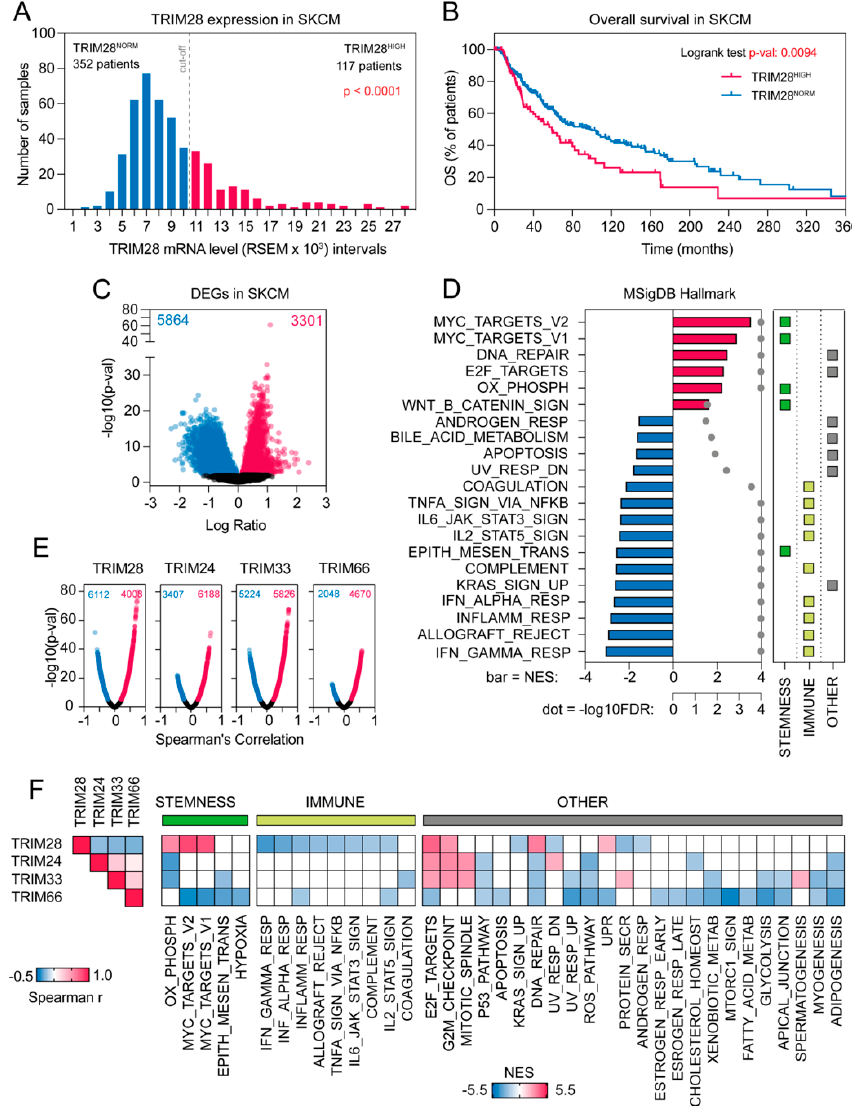
Figure 1. The transcriptome profile of TRIM28 high expressing SKCM TCGA patients negatively correlates with immune-associated gene signatures while being significantly enriched with stemness-associated biological processes. ( A ) Distribution of TRIM28 mRNA expression in the SKCM TCGA patients ( n = 469). RSEM intervals of every thousand units were designated and the number of samples in each interval was plotted. TRIM28 HIGH samples ( n = 117) are presented in magenta; TRIM28 NORM samples ( n = 352) are presented in blue. ( B ) Kaplan–Meier overall survival curves for SKCM TCGA cohort separated into TRIM28 NORM and TRIM28 HIGH subgroups. ( C ) Volcano plot of differentially expressed genes between TRIM28 NORM and TRIM28 HIGH melanoma sub-groups. Blue—genes downregulated in TRIM28 HIGH (upregulated in TRIM28 NORM ). Magenta—genes upregulated in TRIM28 HIGH . Cut-off: p- value ( t- test) < 0.05. ( D ) All significantly differentially expressed genes ( n = 9165) were sorted based on their log2FC value resulting in a pre-ranked gene list that was further used in a GSEA analysis with MSigDB Hallmark gene sets as a reference. Only biological processes with a nominal p-value < 0.05 and FDR < 5% are presented. Note significant downregulation of immune-associated terms and significant upregulation of stemness-associated terms in TRIM28 HIGH group. Bar—Normalized Enrichment Score (NES); gray dot—False Discovery Rate ( − log10FDR). ( E ) Volcano plot of genes correlated with the expression of TRIM28, TRIM24, TRIM33, or TRIM66 expression in SKCM TCGA data. Statistical significance for each correlation ( − log10(p-val)) was plotted against the Spearman’s correlation coefficient. Blue—genes negatively correlated, FDR < 1%; magenta—genes positively correlated, FDR < 1%. ( F ) All significantly correlated genes (FDR < 1%) were sorted based on Spearman’s r value resulting in a pre-ranked gene list that was further used in